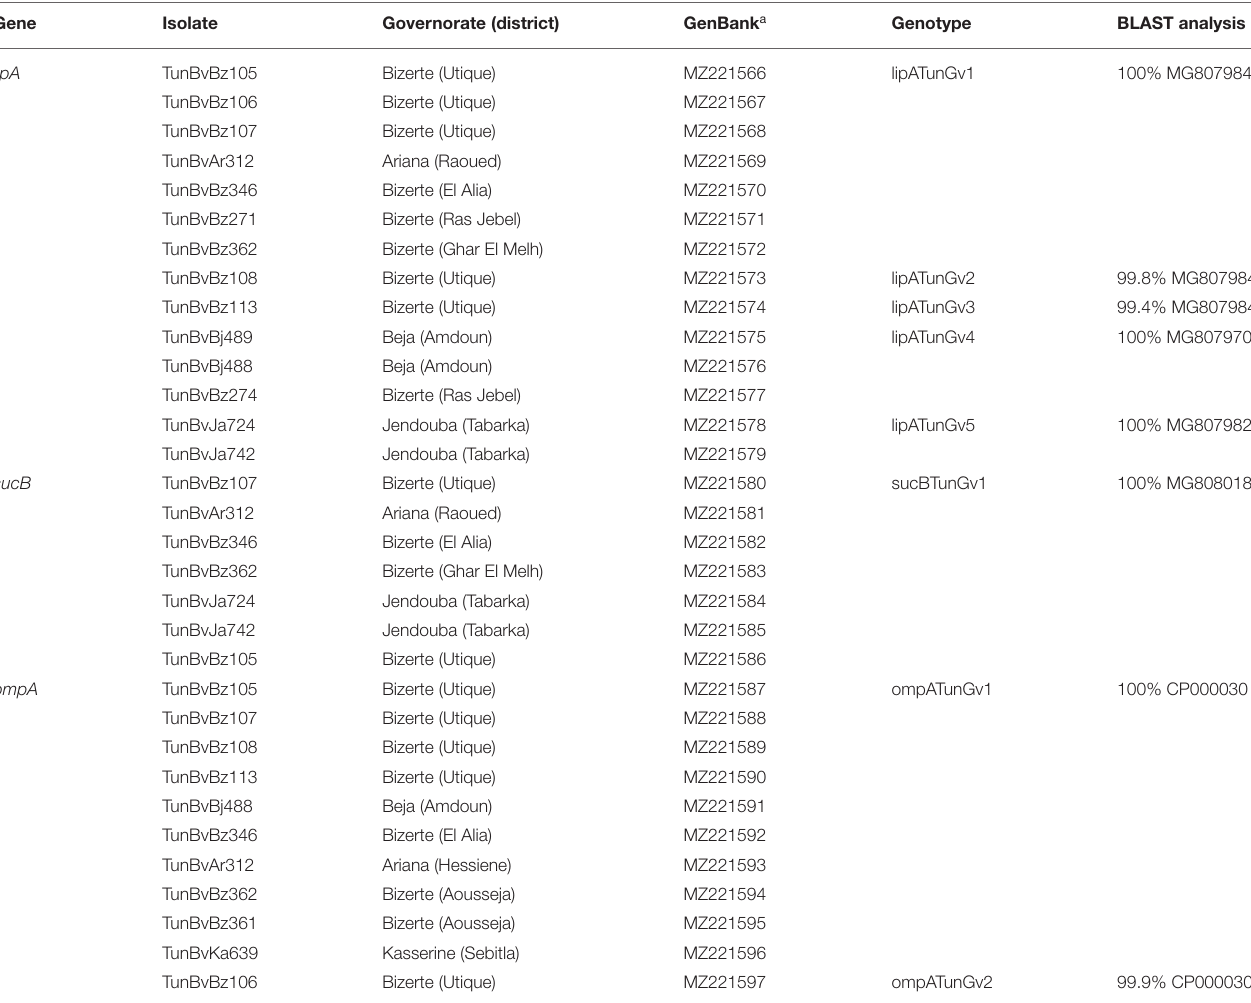
TABLE 2 | Designation and information about sequencing of Anaplasma marginale genotypes identified in this study. Gene